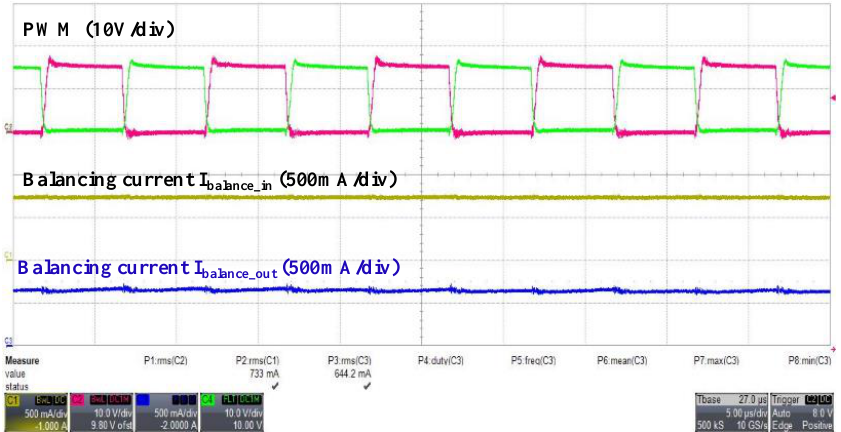
Figure 9. Experimental waveforms of the push-pull converter (PWM waveforms and the balancing Experimental waveforms of the push-pull converter (PWM waveforms and the currents). balancing